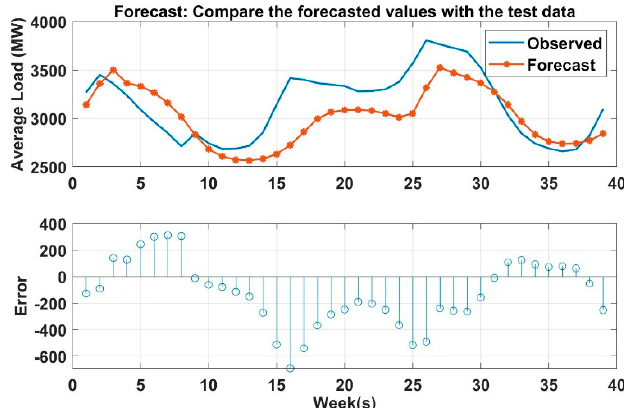
Figure 20. Per-week forecast of future time series.